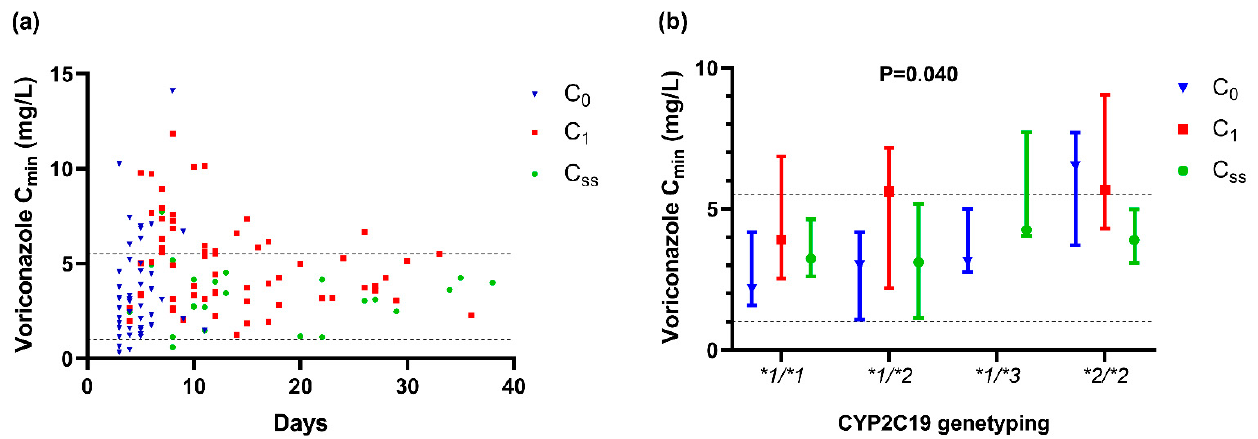
Figure 2. Distinction of voriconazole trough concentration of 43 patients ( a ) as the therapeutic progress by days ( n = 144); ( b ) in different CYP2C19 phenotype groups ( n = 103, p = 0.040). The Kruskal–Wallis test was used to compare C min s of the four groups. Data are expressed as the median ± interquartile range. C min , voriconazole trough concentration; CYP2C19 , cytochrome P450 2C19; C 0 , the first trough concentration after voriconazole therapy; C ss , the final trough concentration; C 1 , the repeated measured trough concentration except C ss . *1 , *2 , *3 , *17 reprented the single nucleotide sequence of genotype of CYP2C19 .